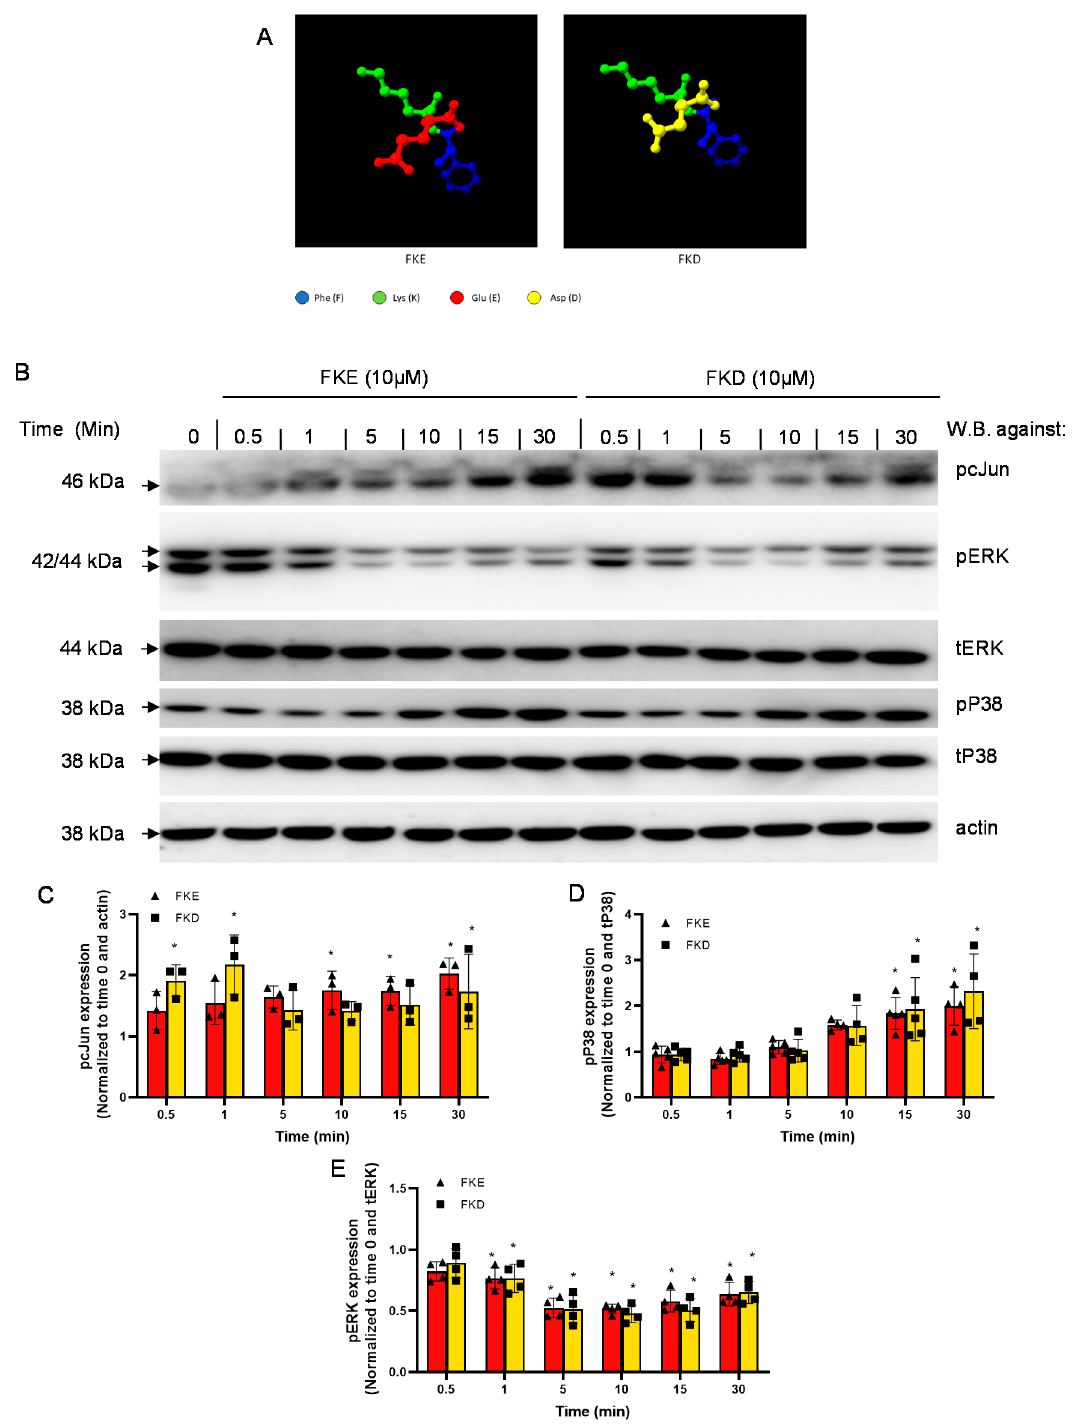
Figure 1. LfP activate P38MAPK and cJun and inhibit ERK in U937-derived human macrophages. U937-derived macrophages were treated with vehicle, FKE or FKD (10 µ M; structure depicted in ( A ) for the indicated periods, then the cells were harvested and protein extracts from the cells were run by 10% SDS-PAGE, and blotted for total or phospho-ERK1 / 2, P38MAPK, and cJun, as well as actin ( B ) using the appropriate primary and secondary antibodies. Densitometric analysis for phospho-cJun ( C ), phospho-P38MAPK ( D ) and phospho-ERK1 / 2 ( E ) are depicted following normalization to actin, total P38MAPK and ERK, respectively, and to untreated cells (Time 0). Results are representative ( B ) and means ± SD from 3–4 experiments. * p < 0.05 compared to untreated cells (Time 0) (ANOVA).